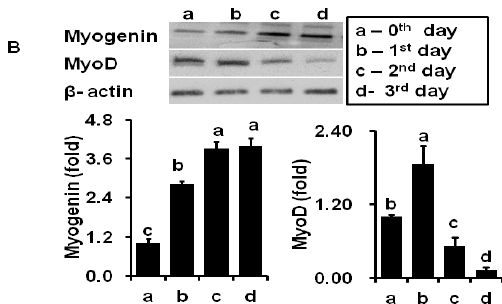
Figure 2. Impact of horse serum on myoblast formation and myogenic markers. ( A ) microscopic views of myoblast differentiation in experimental cells; and ( B ) Western blot analysis of Myogenin and MyoD (myogenic differentiation-1) expression in 2% horse serum (HS) media (a—day 0; b—1st day; c—2nd day; d—3rd day). The results represent the mean ± SEM of three replicates. The different letters—a, b, c, d,—within a treatment indicates significant differences ( p < 0.05).